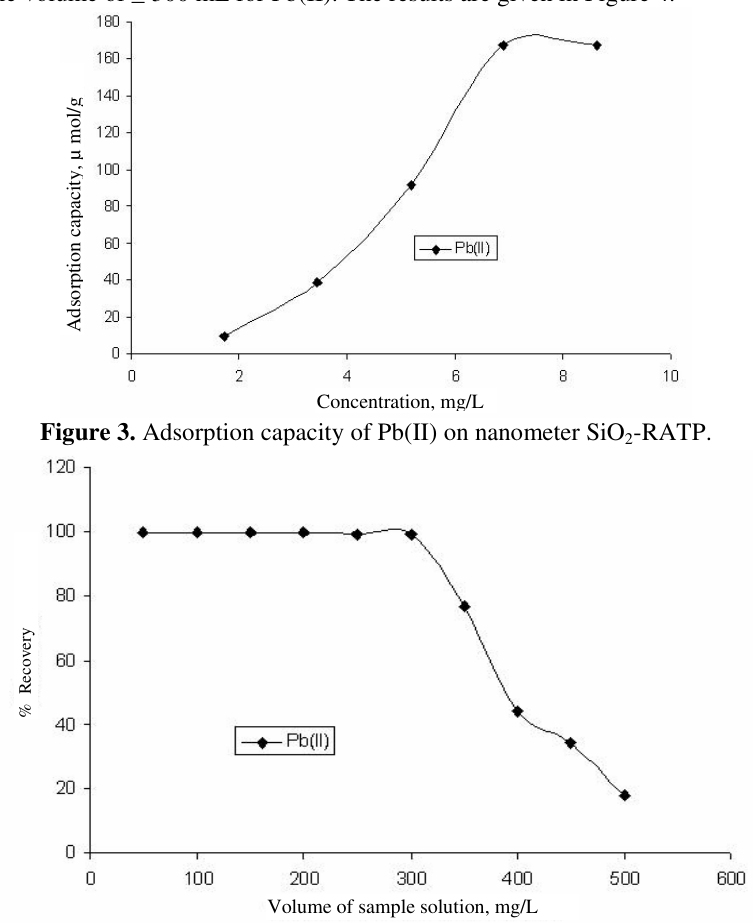
Figure 4. Effect of sample volume on analyte